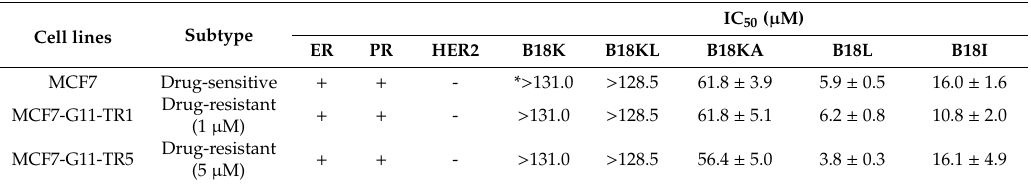
Table 3. Activity of B18L against DSBC and DRBC cell lines for 24